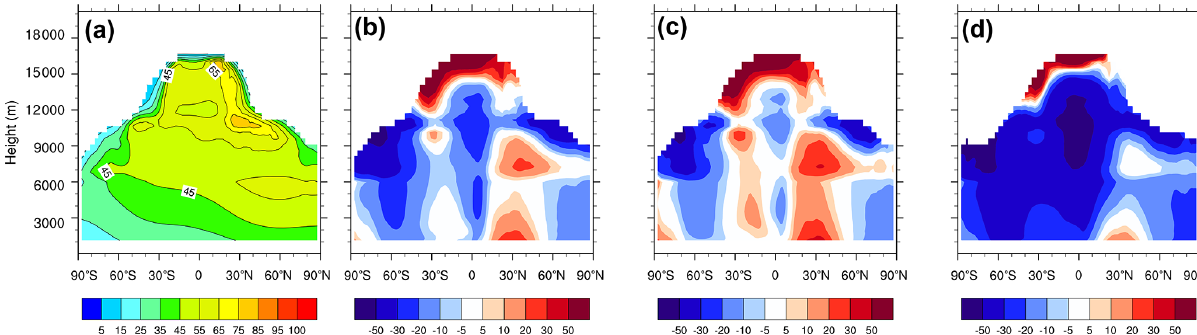
Figure 15. Zonal distribution of tropospheric ozone concentration (ppbv) for the year 2006: (a) observed distribution based on the global monthly mean vertical ozone profile database available from Bodeker Scientific; (b) the relative difference (%) between the concentration modelled using the default PR92 lightning parameterisations (Run 1) and the observations; (c) the relative difference (%) between the concentration modelled using the new lightning parameterisations (Run 2) and the observations; and (d) the relative difference (%) between the concentration modelled without any LNO x and the